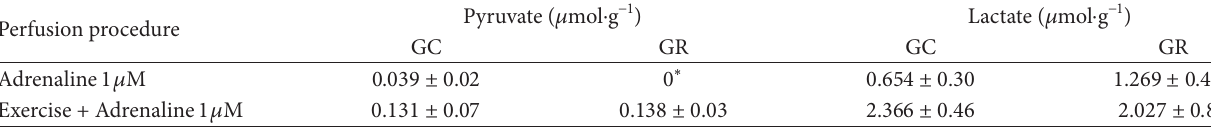
Table 4: AUCs for the liver release of pyruvate and lactate.